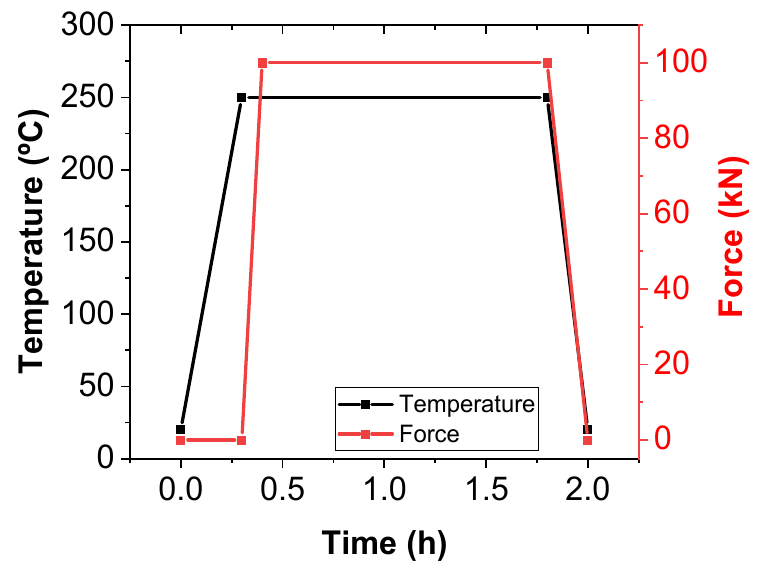
Figure 1. Hot-press force and temperature cycle for manufacturing bulk CNT–Surlyn nanocomposites from their pellets.